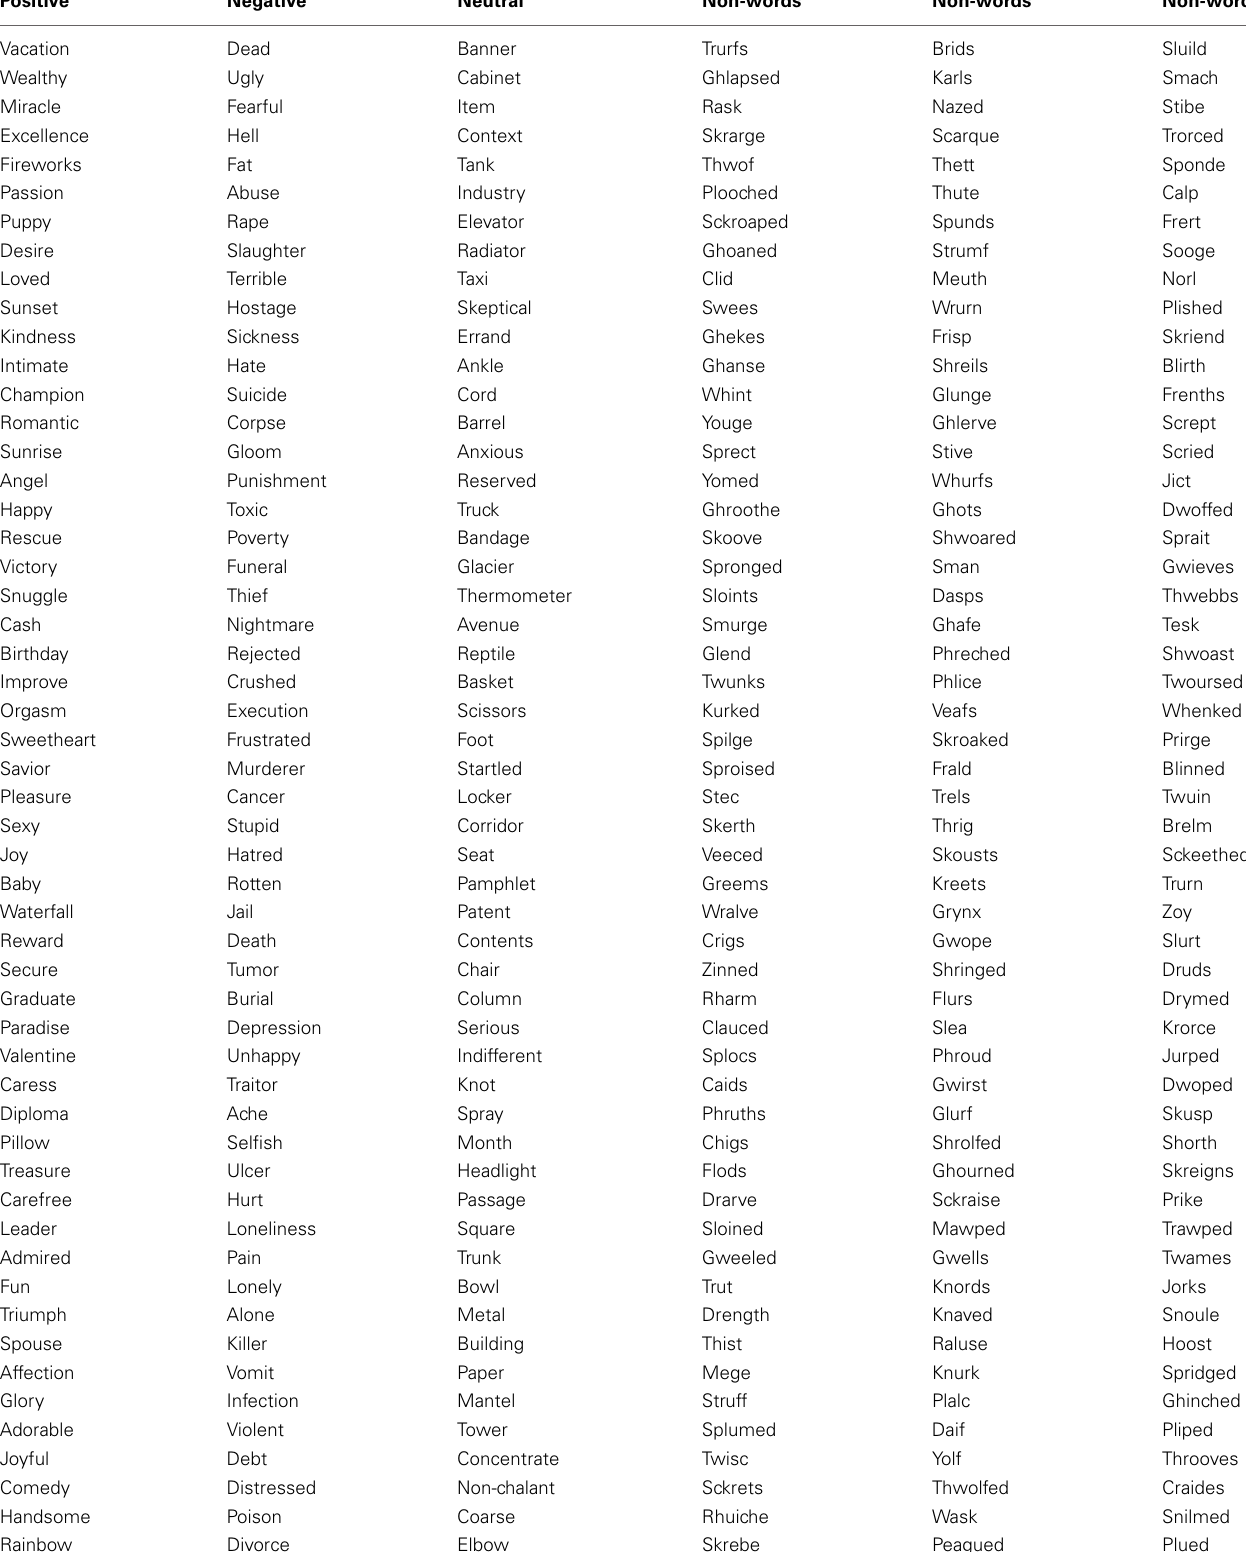
Table 2 | Post-election word